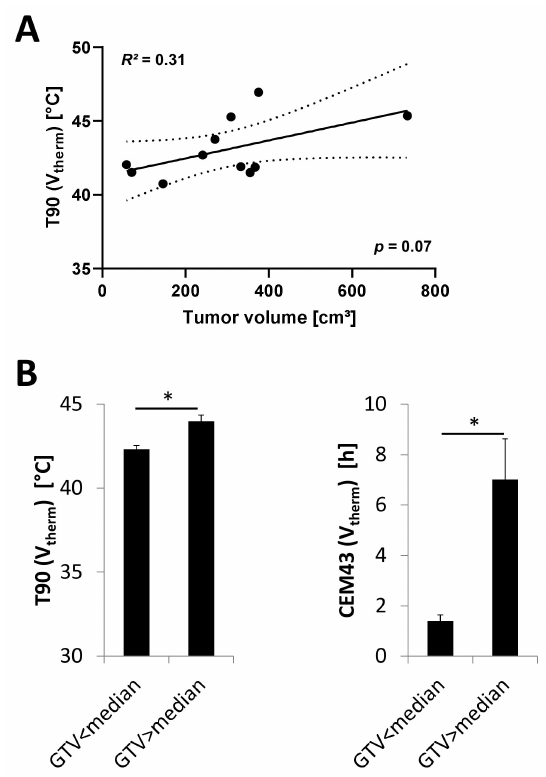
Figure 4. Mean T90 (V therm ) for all timepoints of all hyperthermia treatments for individual patients showed a moderate correlation with a trend to statistical significance with the contoured tumor volume. Large tumors tended to reach higher temperatures ( A ). T90 (V therm ) as well as CEM43 (V therm ) was significantly higher for tumors with GTV volume above the median compared to tumors with GTV size below the median ( B ). * p <